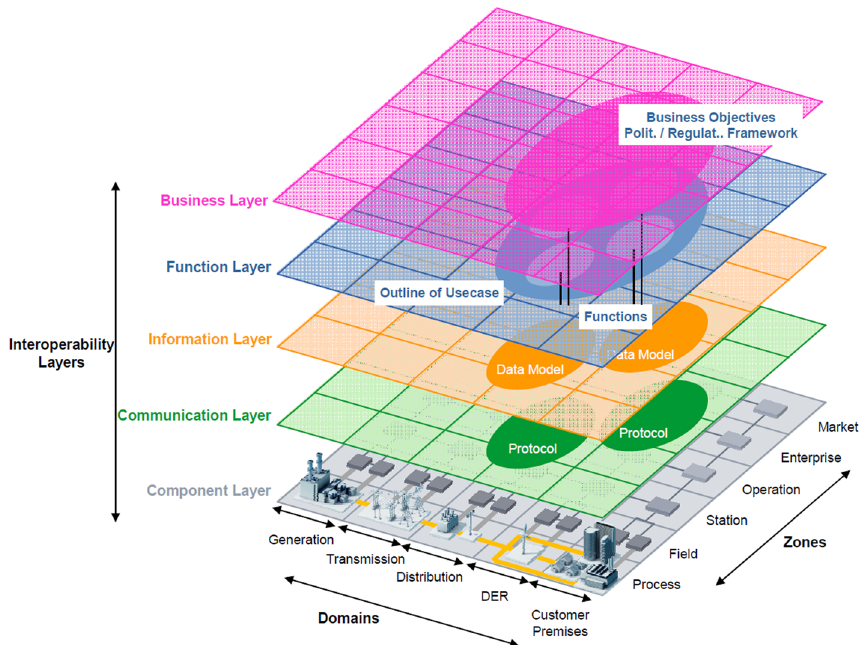
Fig. 1 The SGAM framework (Bruinenberg et al.